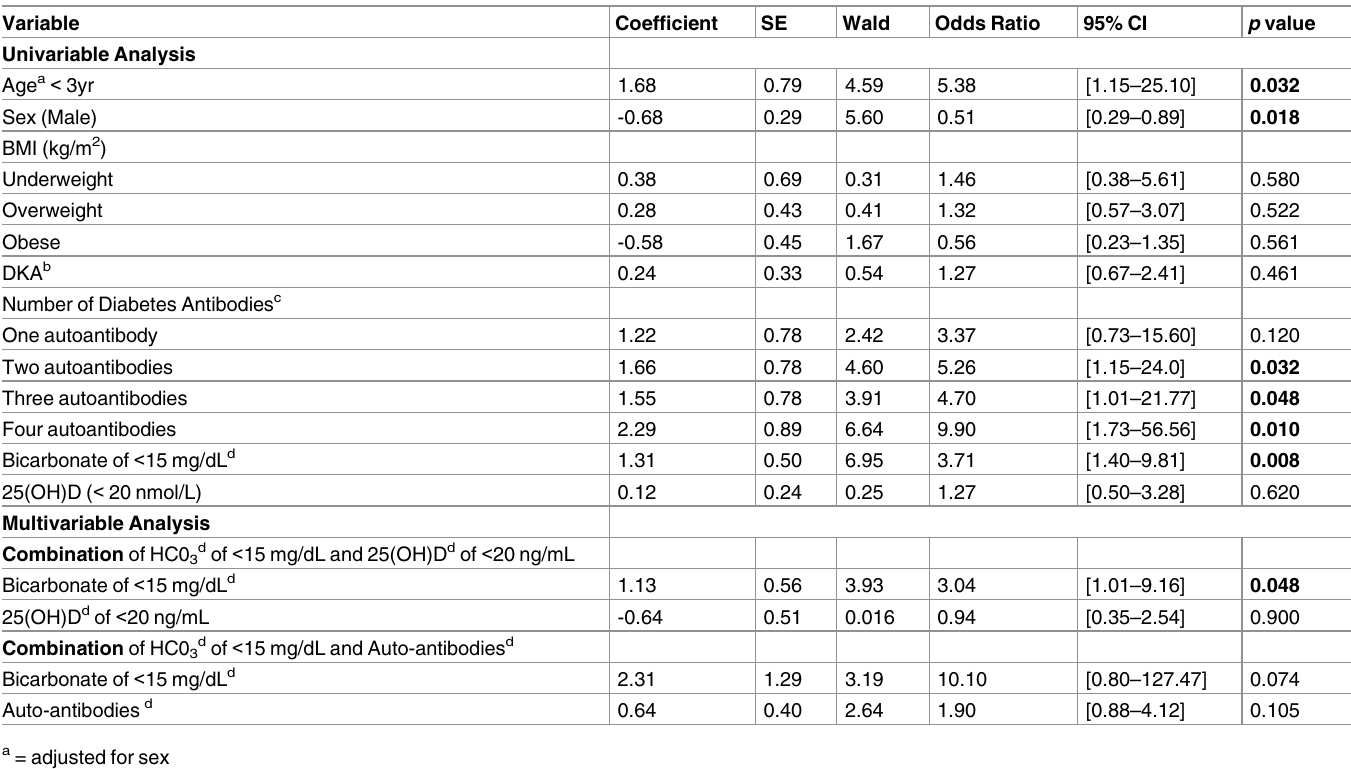
Table 2. Univariable and multivariable logistic model for determinants of non-remission in new-onset pediatric type 1